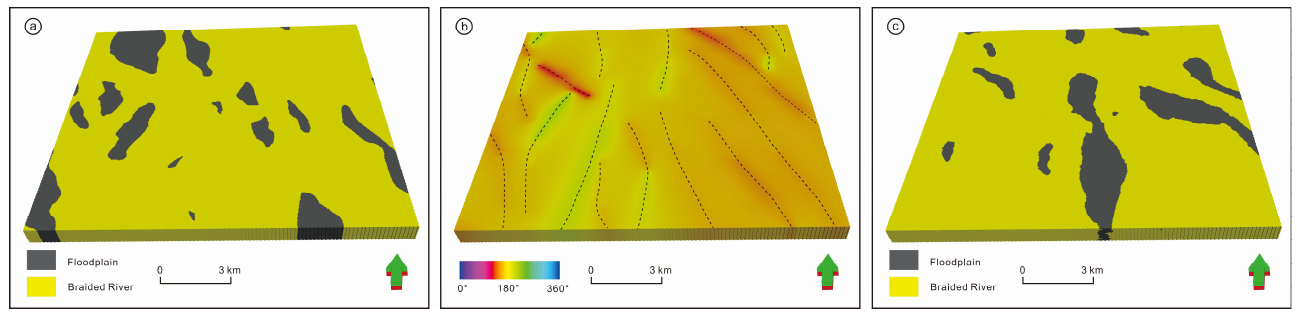
Figure 7. First hierarchical modeling. ( a ) First hierarchical TI 1-1 based on 5-level architecture units, ( b ) direction attribute body based on main streamline of river, ( c ) first hierarchical multiple-point geostatistical simulation results MPS-1 based on 5-level architecture units.